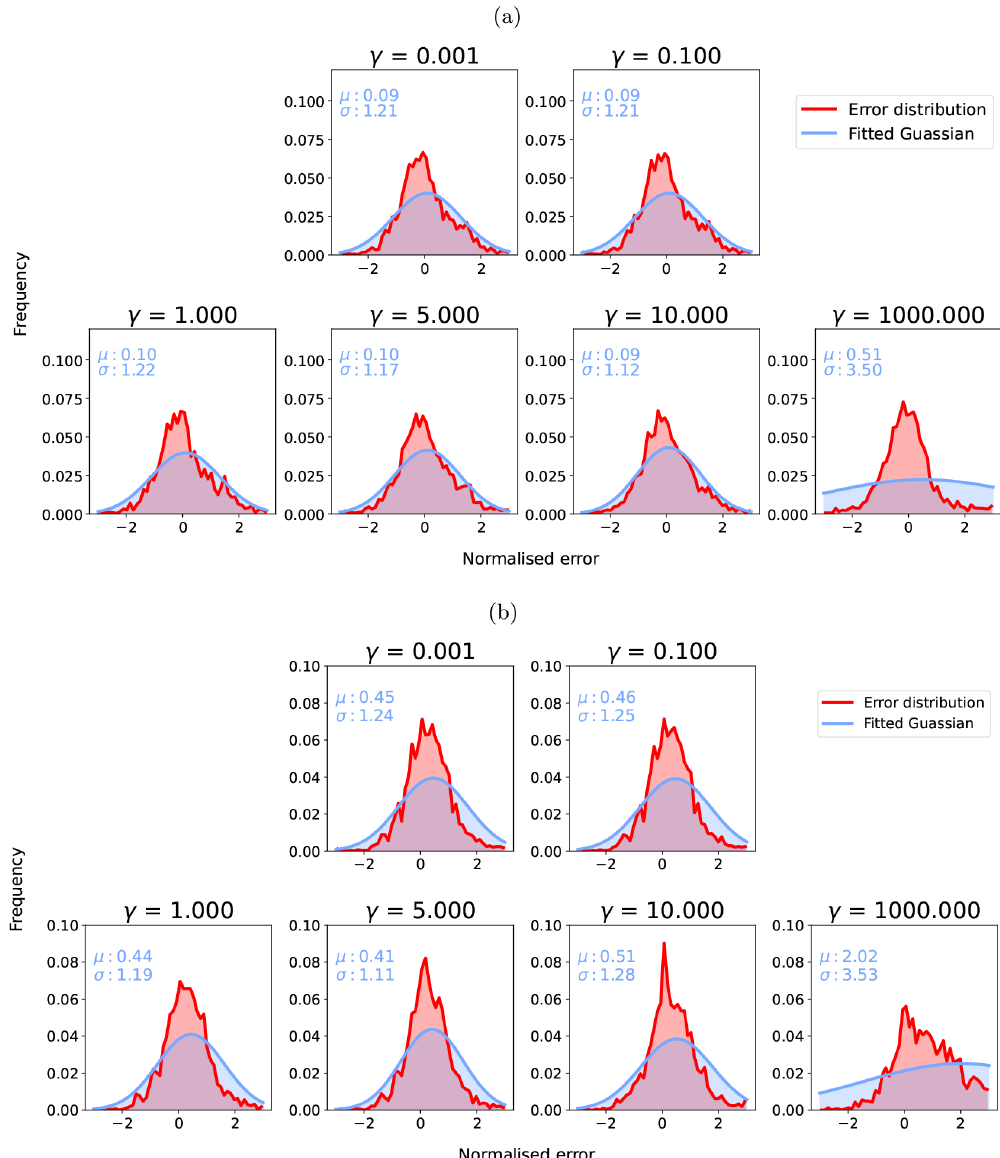
Figure 10. Standardised residual (cid:15) x distributions for S2 TCWV (a) and L8 TCWV (b) with γ of [0.001, 0.1, 1, 5, 10, 100, 1000]. The atm red histogram distributions show standardised error distributions (Error distribution) from the data and the blue ones the estimated Gaussian distribution from the distributions (Fitted